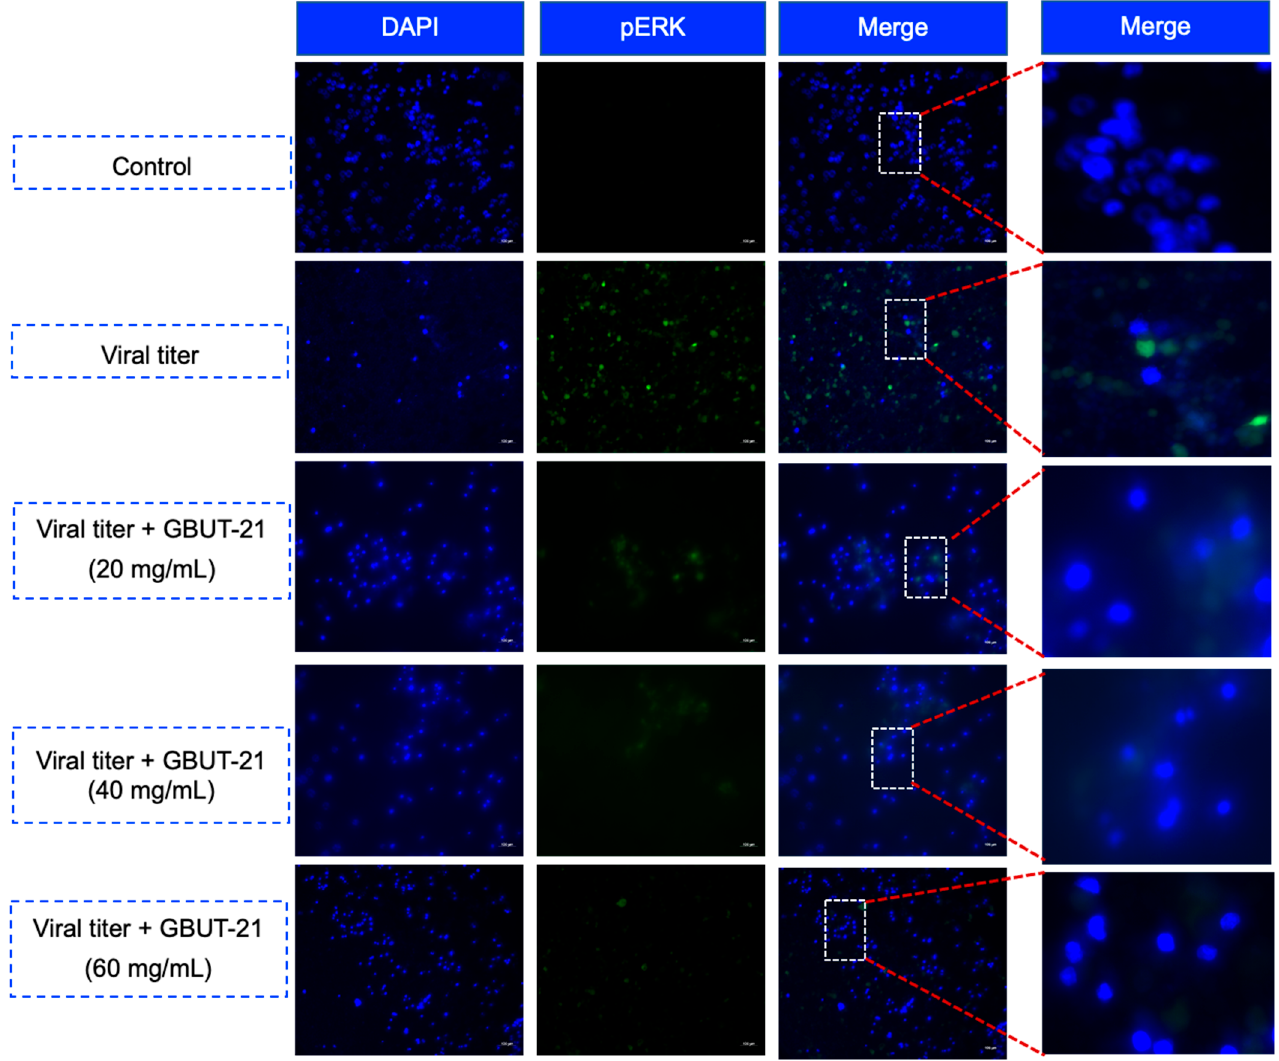
Figure 4. The influence of GBUT-21 on p-ERK protein in HEK293 cells after infection with SARS-CoV-2.